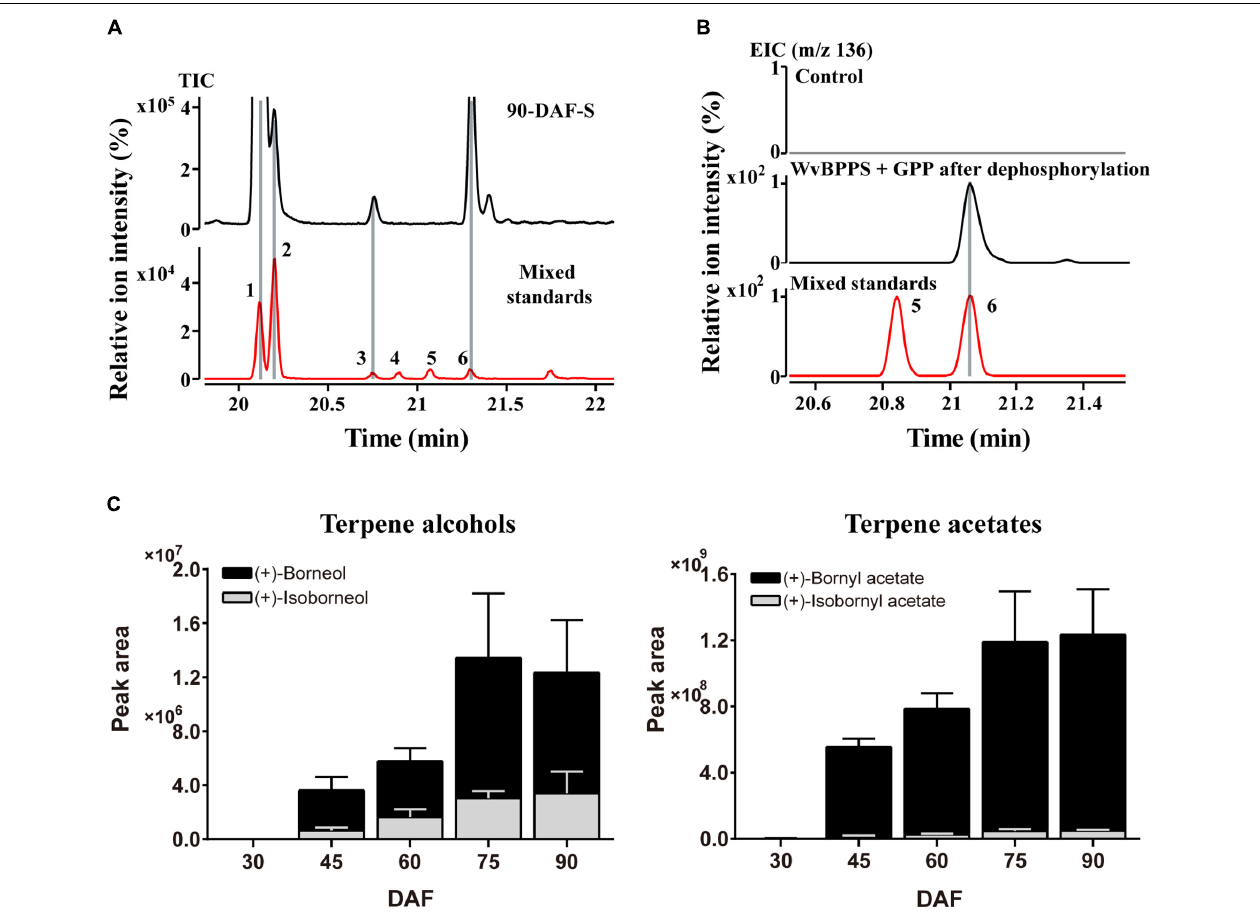
FIGURE 6 | (A) The GC-MS chromatogram of the volatile terpene in the 90-DAF seeds of Wurfbainia villosa , and the mixed standards. (B) The GC-MS chromatogram of the products generated by WvBPPS protein after dephosphorylation and the mixed-borneol standard and its negative control was treated with boiled protein. The compounds of peaks: 1. bornyl acetate; 2. isobornyl acetate; 3. (+)-isoborneol; 4. ( − )-isoborneol; 5. ( − )-borneol; 6. (+)-borneol. (C) The GC-MS chromatographic peak (EIC, m/z 136.0) areas of (+)-borneol, (+)-isoborneol and their corresponding acetates (+)-bornyl acetate and (+)-isobornyl acetate, in seeds at different developmental stages of W. villosa